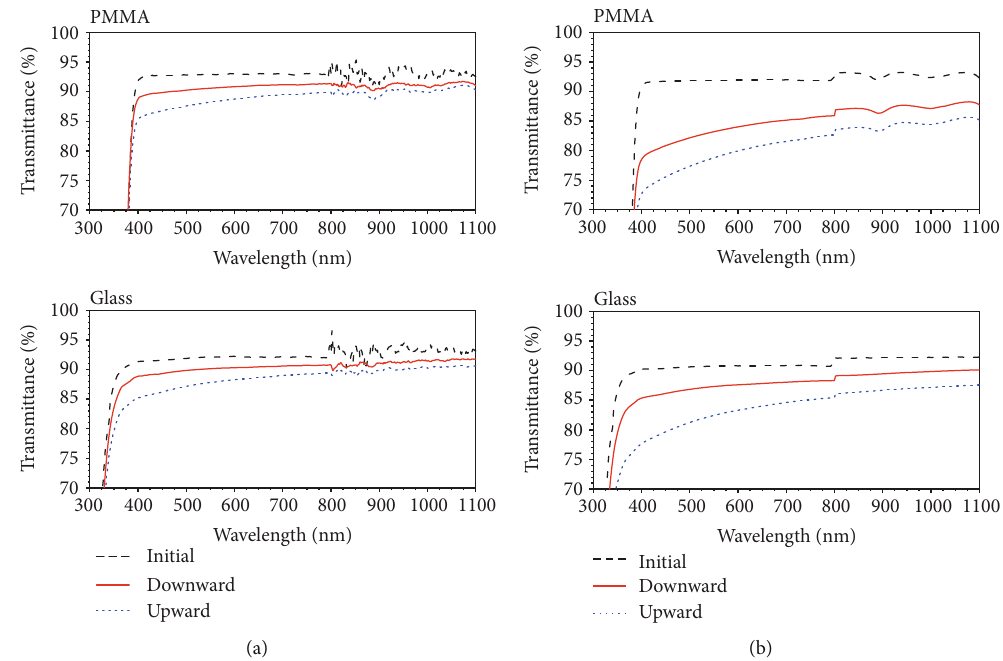
Figure 2: Transmittances of the PMMA and glass substrates on the downward and upward systems after 20 months of exposure (May 24, 2016) measured (a) with and (b) without an integrating